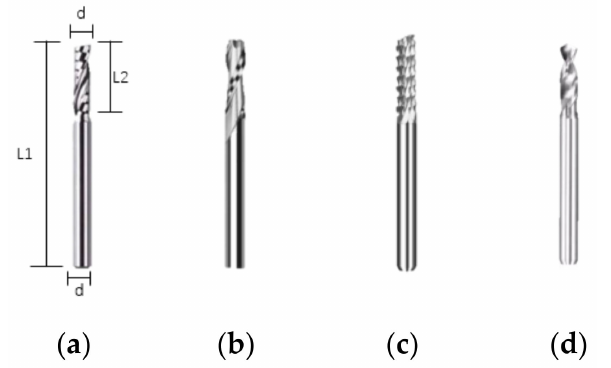
Figure 1. Schematic of cutting tools: ( a ) Single-edge milling cutter; ( b ) Double-edge milling cutter; ( c ) Corn milling cutter; ( d ) PCB alloy